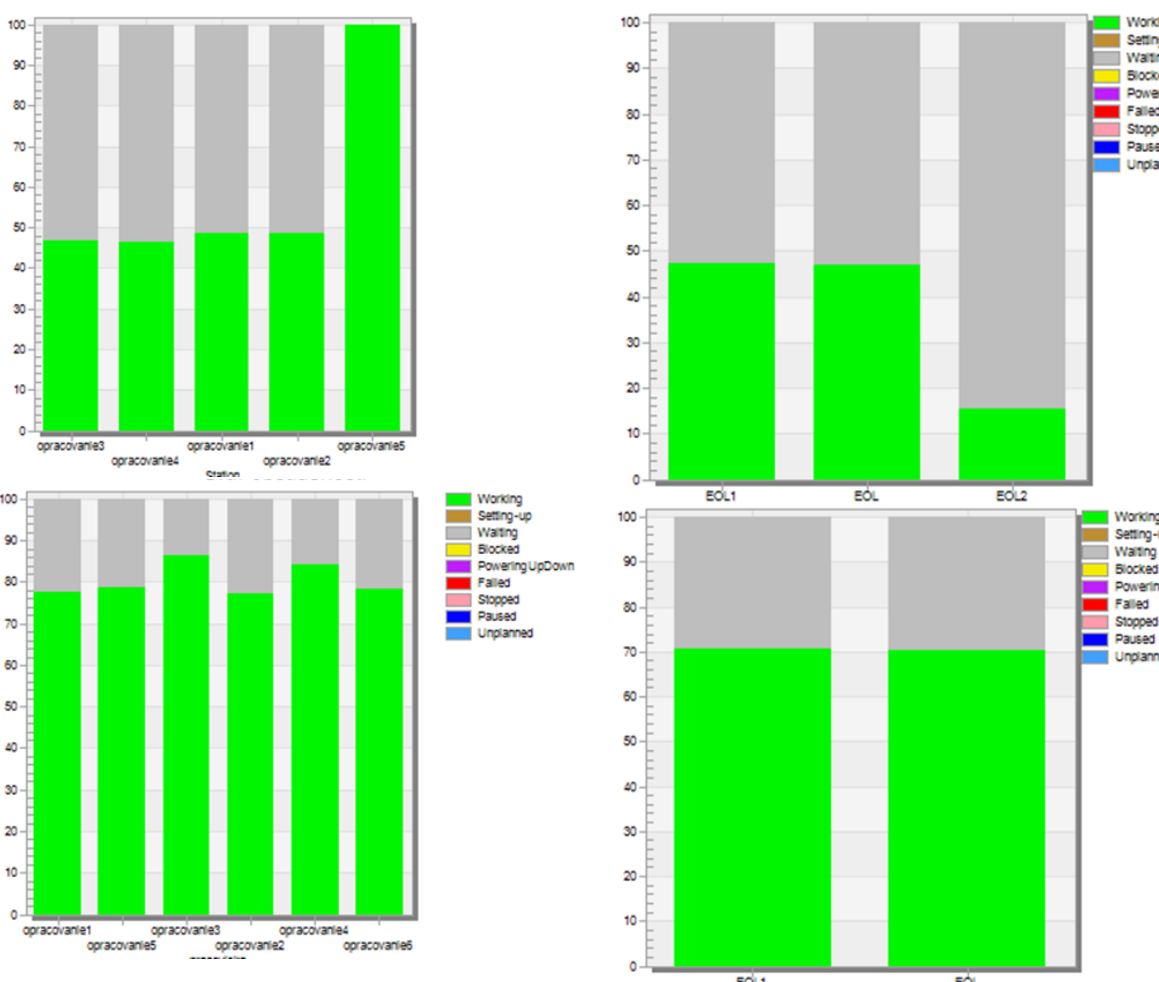
tity, but the utilization of workplaces changed minimally. The next step was to increase the number of entities by